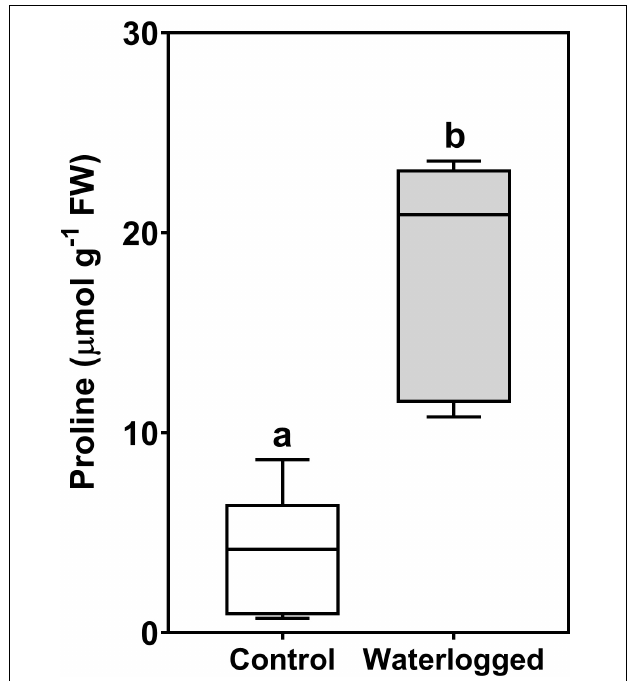
FIGURE 9 | Boxplots of proline content in leaves of control plants (white box) and waterlogged plants (gray box) of Spartina patens after 30 days ( n = 5, different letters indicate significant differences at p <